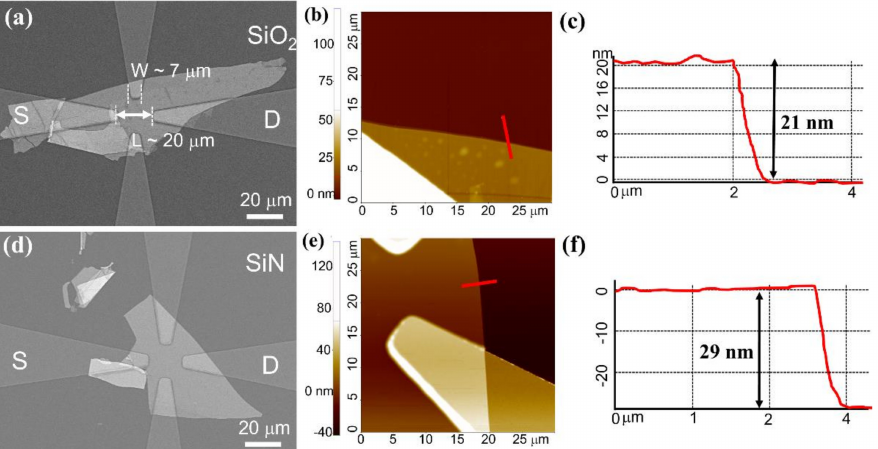
Figure 2. ( a ) SEM image of MoSe 2 /SiO 2 /Si (magnification 1k); ( b , c ) the corresponding AFM image and topographic analysis, respectively. ( d ) SEM image of MoSe 2 /SiN/Si (magnification 1k); ( e , f ) the corresponding AFM image and topographic analysis,